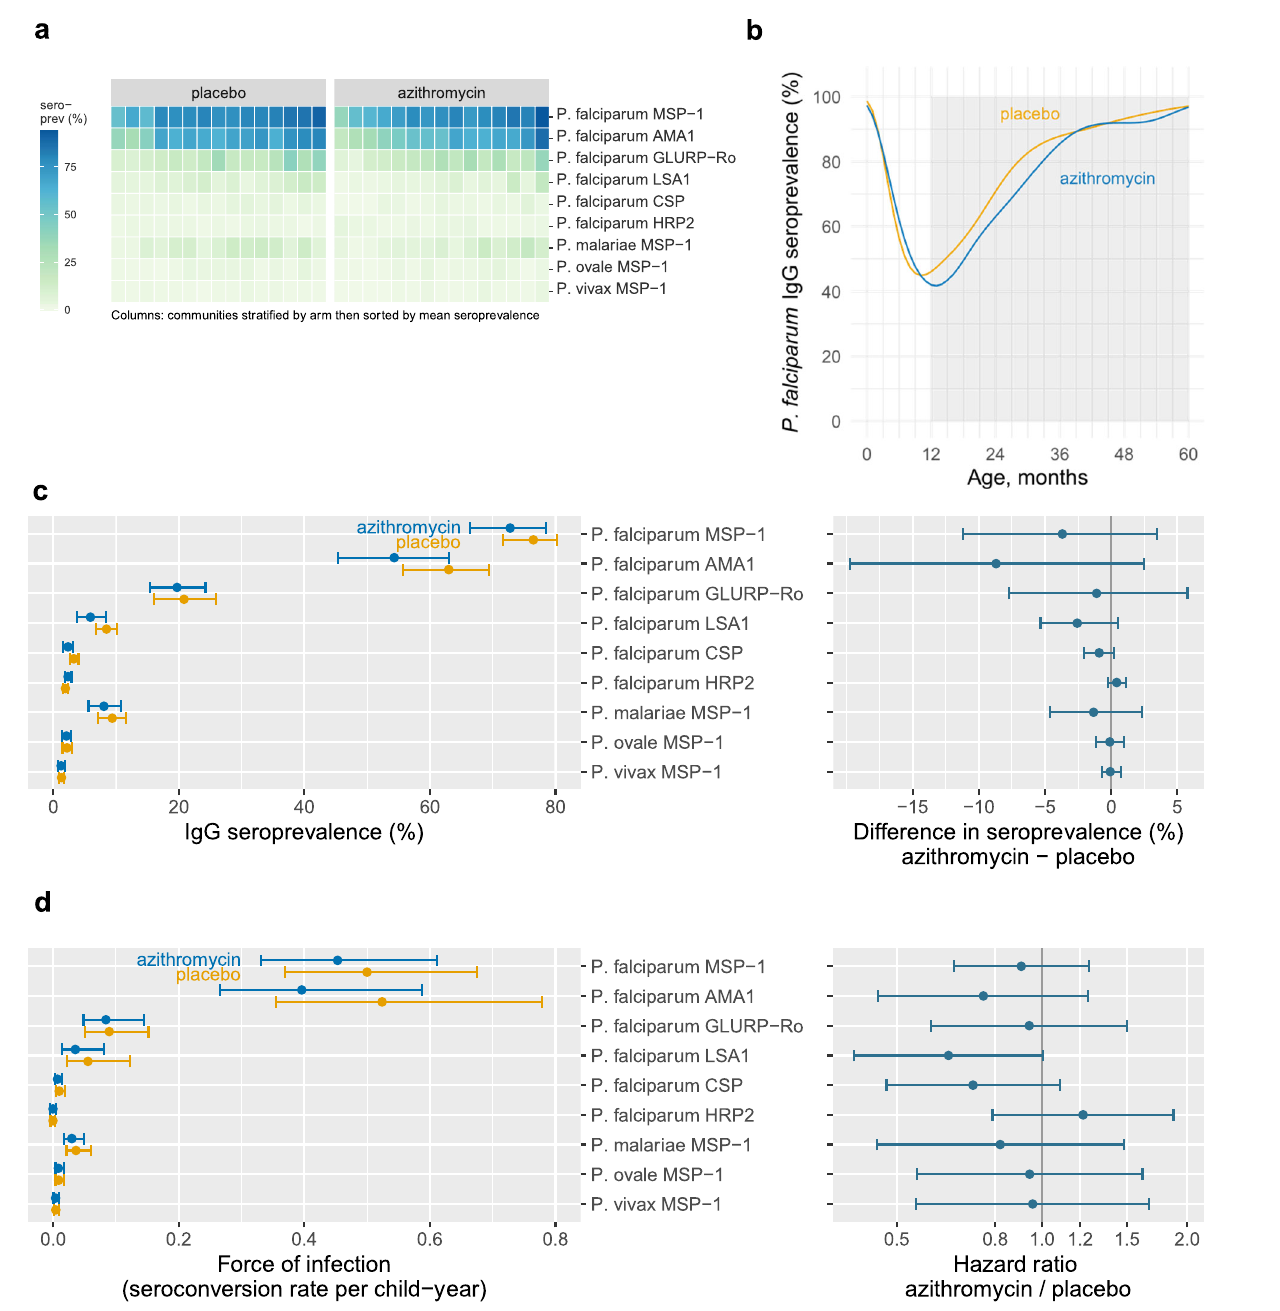
Fig. 2 Malarial IgG antibody responses by treatment group. Estimates from 3860 children ages 12 – 59 months in the MORDOR Niger trial, 2015 – 2018. a Community-level seroprevalence to malarial antigens. Columns represent individual communities, which were strati fi ed by treatment group and then sorted by overall mean seroprevalence. b Mean IgG seroprevalence to P. falciparum (positive to any measured antigen) by age and treatment group (lines), estimated with semiparametric splines. The shaded region from 12 to 59 months indicates the age range included in the primary analysis. c Antigen- speci fi c IgG seroprevalence by treatment group and difference between groups. Points indicate group means and mean the difference between groups, error bars indicate 95% con fi dence intervals. d Antigen-speci fi c force of infection estimated by the seroconversion rate, and hazard ratio for comparison between groups. Points indicate group means and the hazard ratio between groups, error bars indicate 95% con fi dence intervals. No between-group comparisons were statistically signi fi cant at the 95% con fi dence level after false discovery rate correction. Created with notebooks https://osf.io/b2v3r, https://osf.io/37ybm, https://osf.io/fwxn5, which include detailed point estimates and additional, consistent results based on geometric mean IgG